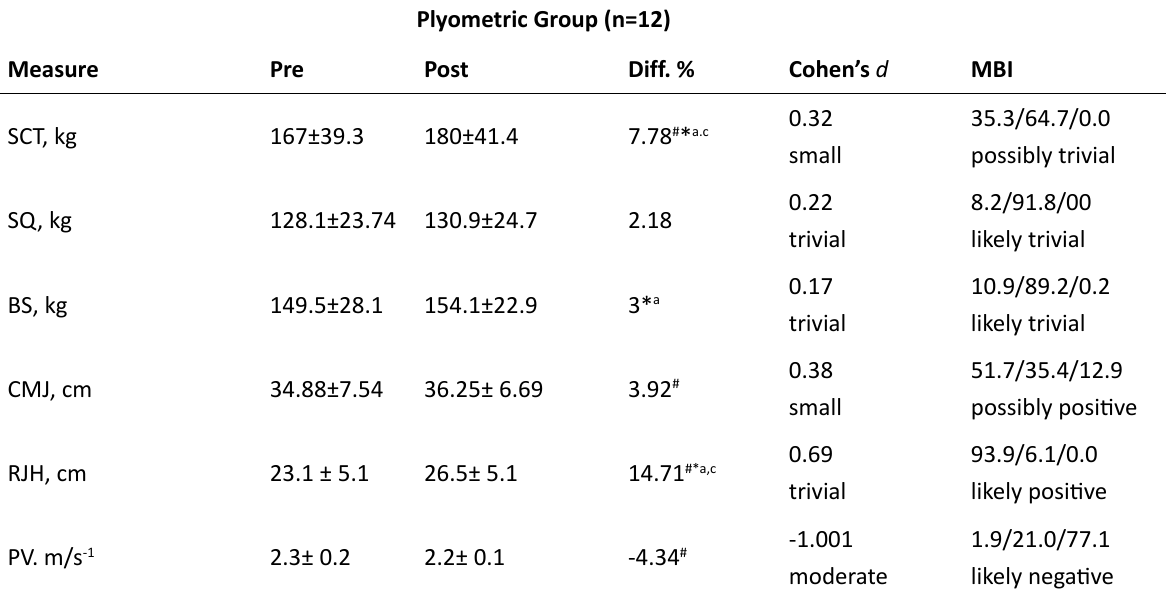
Table 4. Pretesting and Posttesting Results of Plyometric